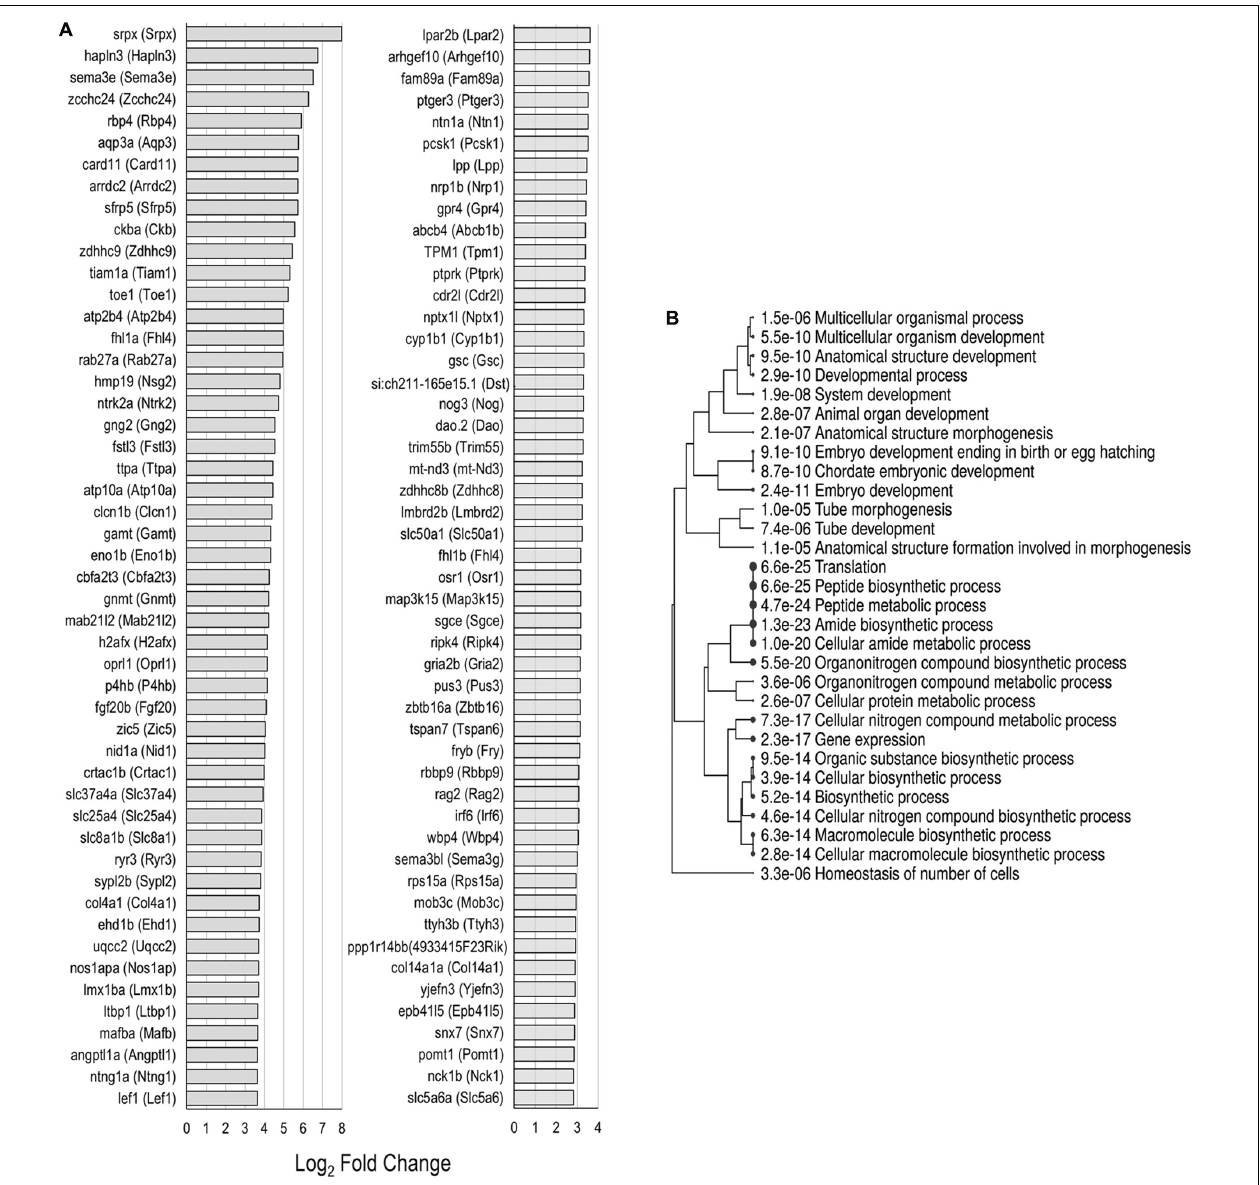
FIGURE 5 | Unique upregulated genes in nsSCs. (A) Log2 fold change values of the top 50 high-confidence gene orthologs uniquely upregulated in zebrafish nsSCs ( n = 386) compared to HCs. (B) ShinyGO analysis identified enriched biological processes of uniquely upregulated zebrafish nsSC genes.